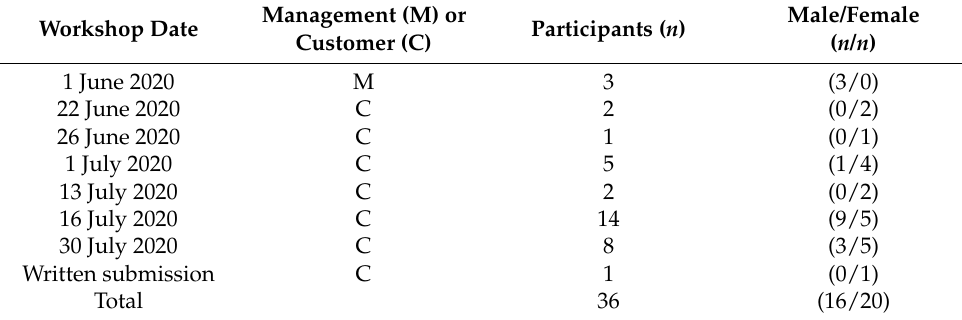
Table 1. Dates of workshops and participant information.